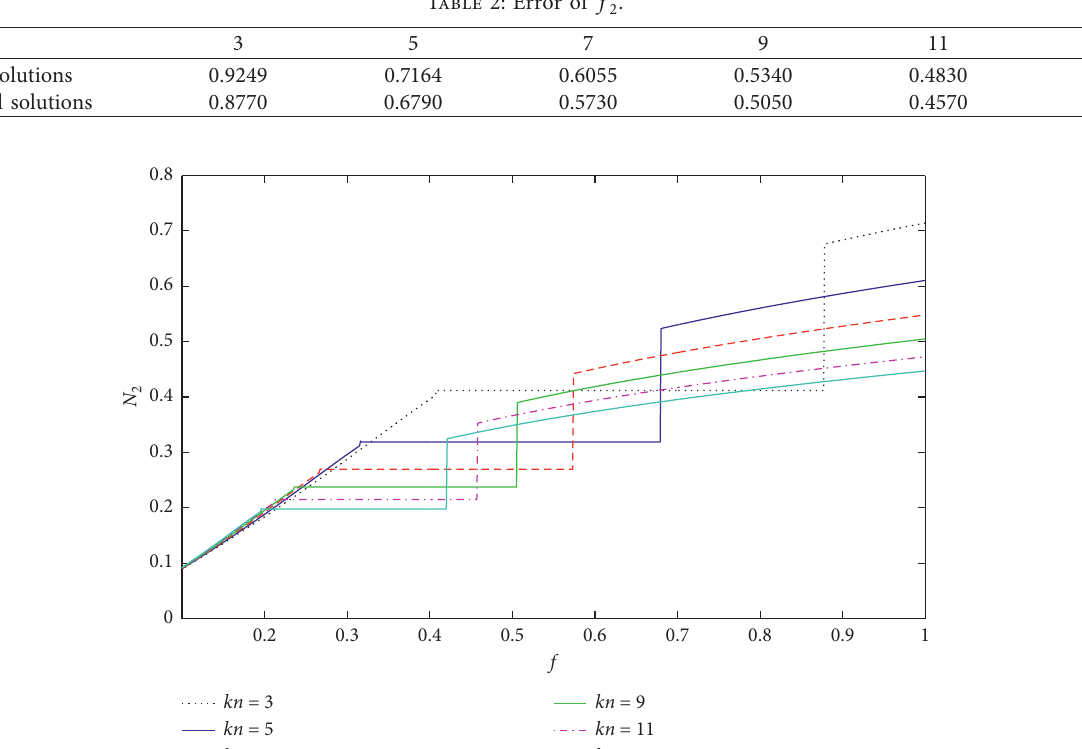
Table 2: Error of f